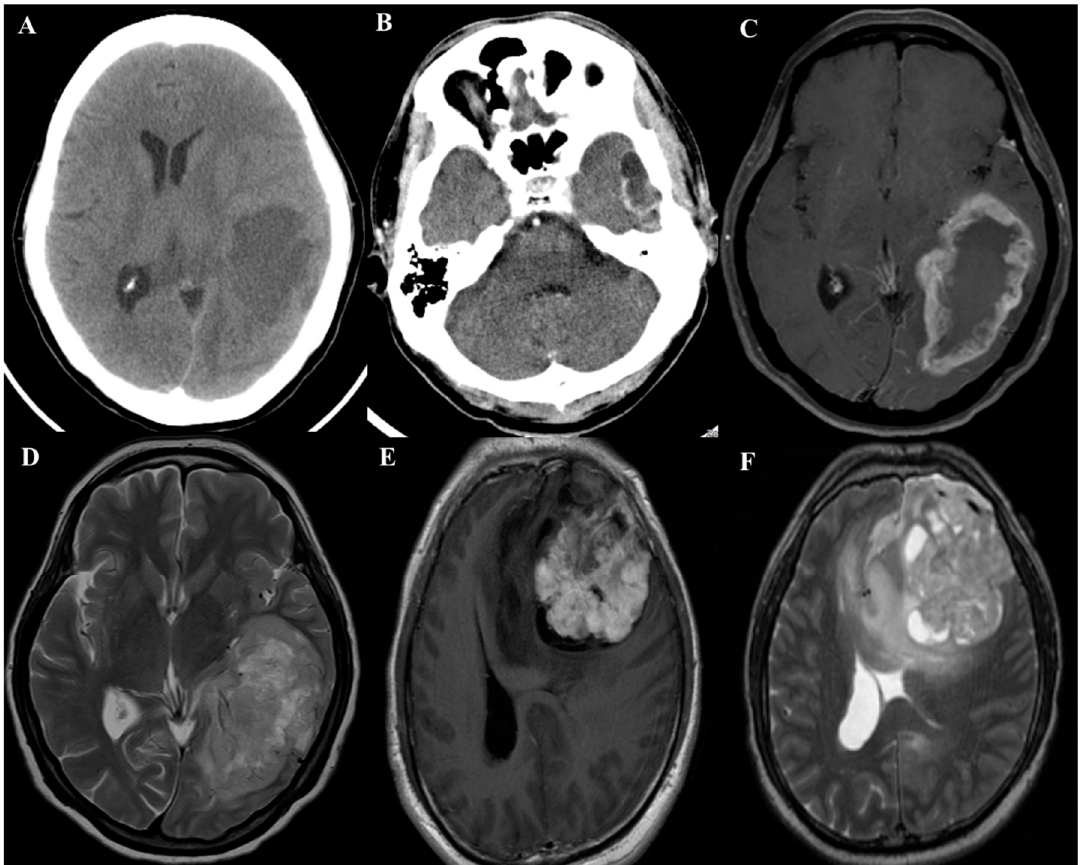
Figure 1. GBM. ( A ) The axial brain CT without contrast shows an irregular mass with central necrosis over the left temporo-parieto-occipital lobes with prominent edematous effect with midline-shifting. ( B ) The axial brain CT with contrast shows multiple lobulated cystic structures with enhanced wall and septi over the left temporal lobe. ( C ) The axial brain magnetic brain imaging, T1-weighted repetition time (TR), 450 ms; echo time (TE), 10 s, Achieva 1.5 T, Philips] image with gadolinium contrast demonstrated an irregular rim enhanced mass with large central necrosis at the left temporo-parieto-occipital lobes. The prominent edematous effect completely compressed the occipital horn of the left lateral ventricle. ( D ) The axial brain MRI, T2-weighted (TR, 4980 ms; TE, 100 s) image with gadolinium contrast demonstrated an irregular ovoid mass with necrosis at the left temporo-parieto-occipital lobes. The edematous effect and mass effect were prominent. ( E ) The axial brain MRI, T1-weighted image with gadolinium contrast demonstrated an irregularly enhanced mass with central necrosis involving the left frontal lobe. The prominent edematous change resulted in brain herniation across the midline. ( F ) The axial T2-weighted image showed a remarkable perifocal edema in the left frontal lobe, extending to the insula, and corpus callosum genu with subfalcine herniation.